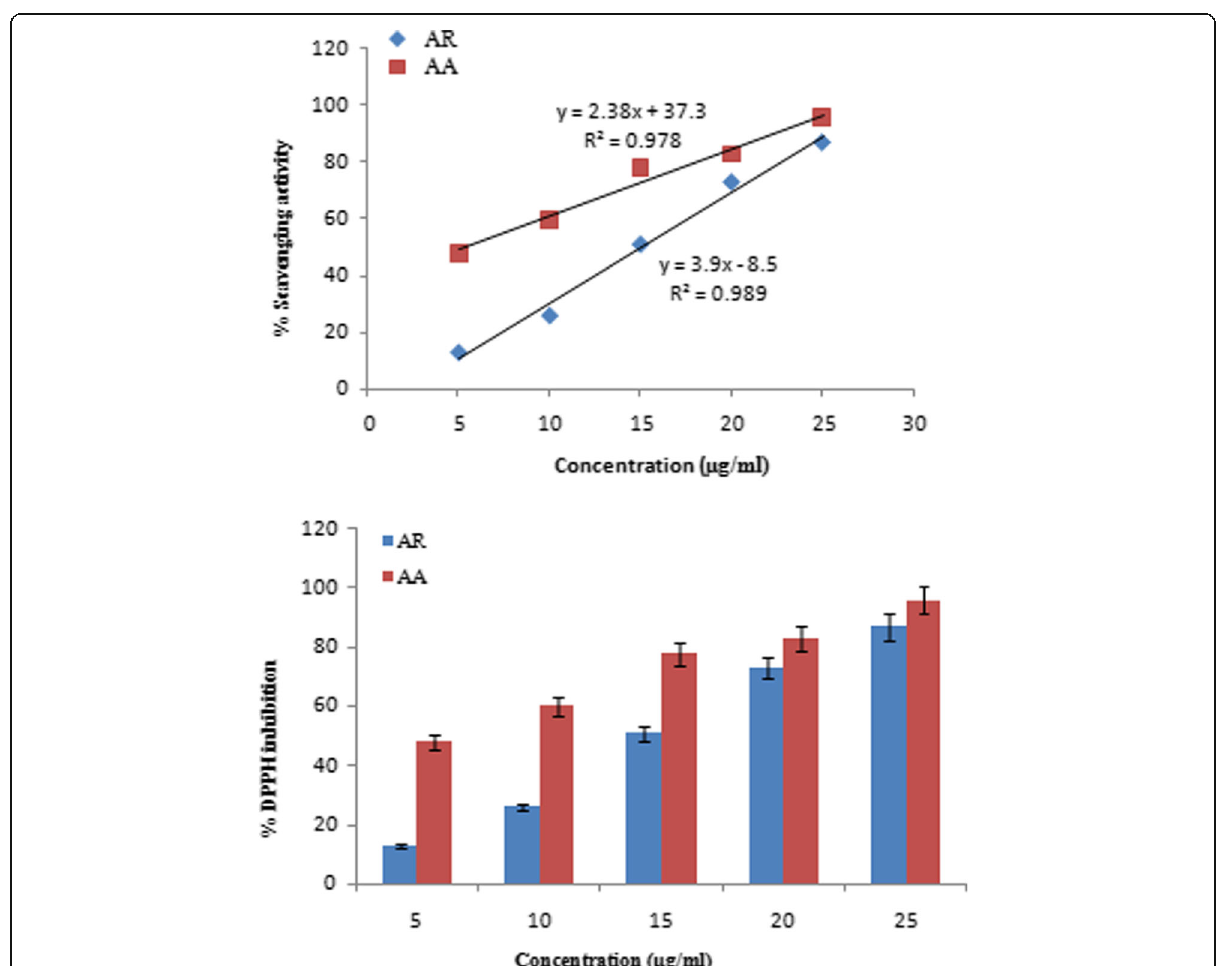
Fig. 2 Scavenging of DPPH free radical by AR rhizome extract. a ) The linear regression curve and b ) Percent of DPPH inhibition. Data represent the mean of three replicates. Ascorbic acid was used as standard. **AR- Astilbe rivularis, AA- Ascorbic